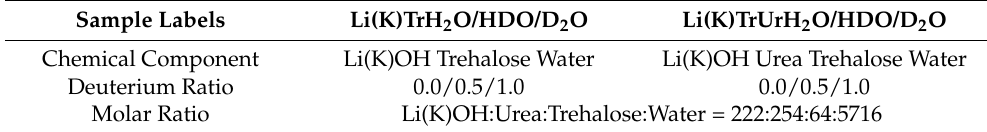
Table 1. Sample labels, chemical components, deuterium ratios and molar ratios of the